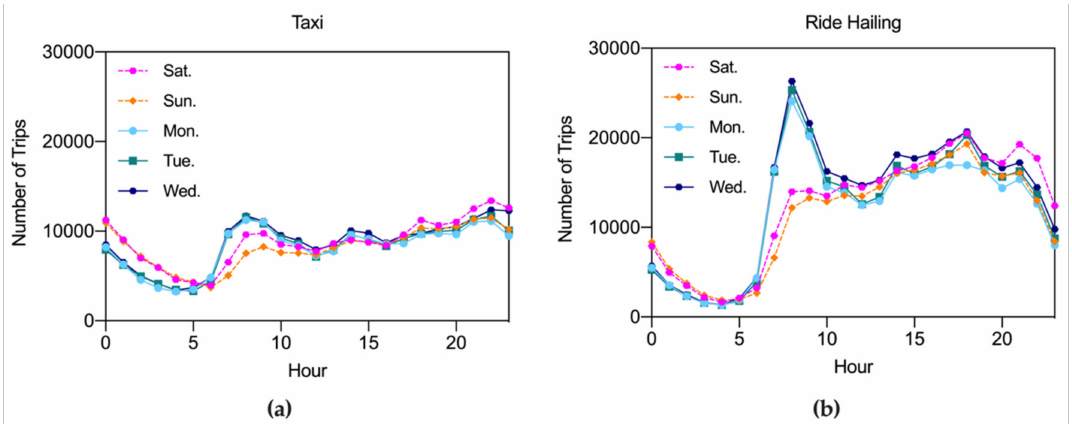
Figure 2. Hourly variation of the numbers of ( a ) taxi trips and ( b ) ride-hailing